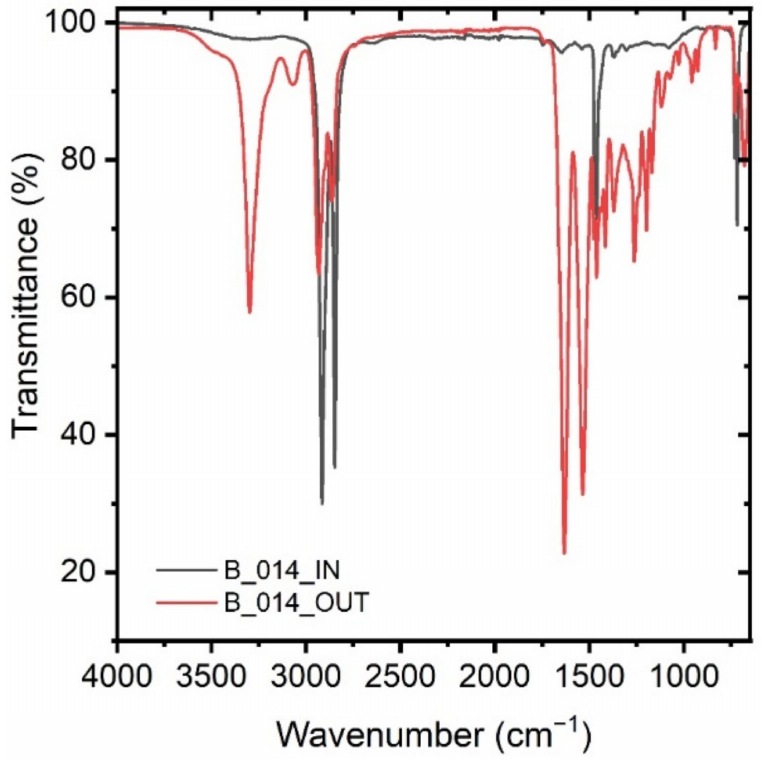
Figure 2. FTIR ATR spectra of a PE, PA multilayer specimen from the inner PE side (grey) and the outer PA side (red). Table 2. FTIR ATR characteristic bands of PE and their assignment [13–15].